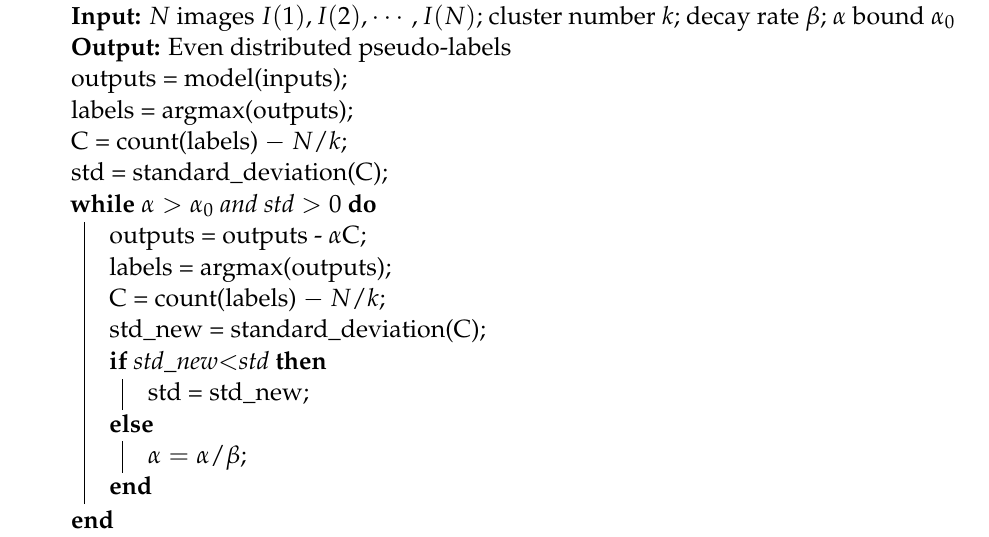
Algorithm 1: Creating even distributed pseudo-labels by output